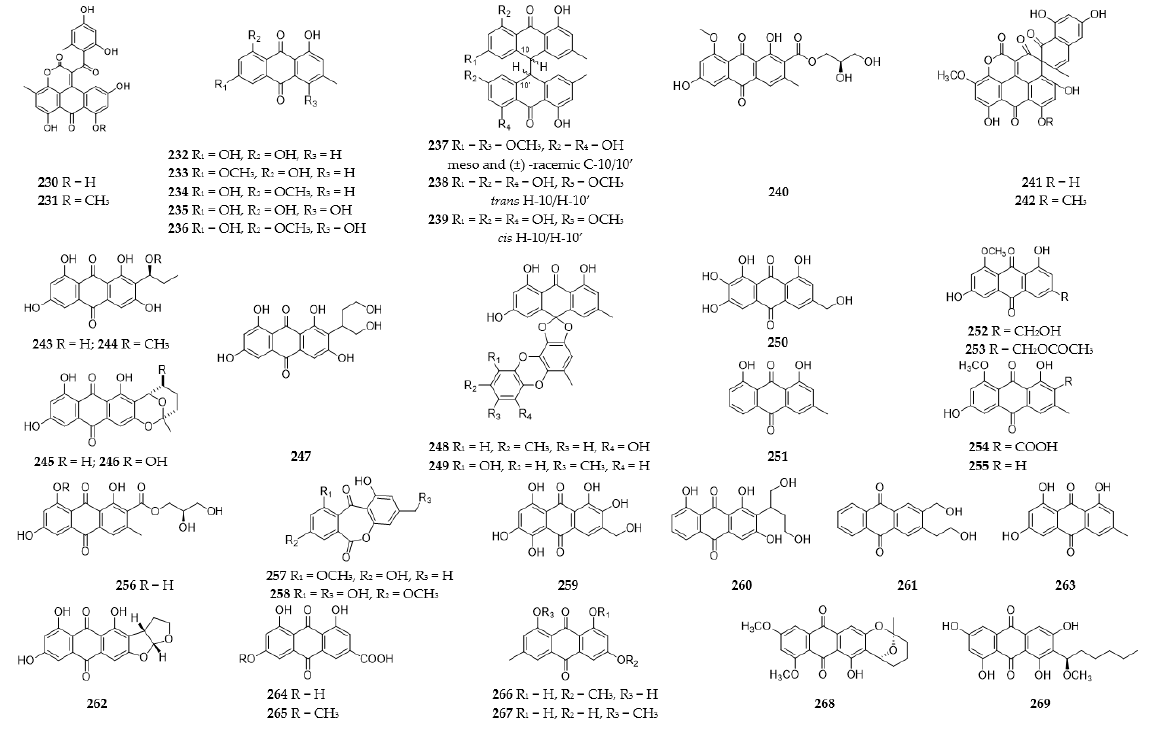
Figure 15. Aspergillus -derived anthraquinones ( 230 – 269 ).